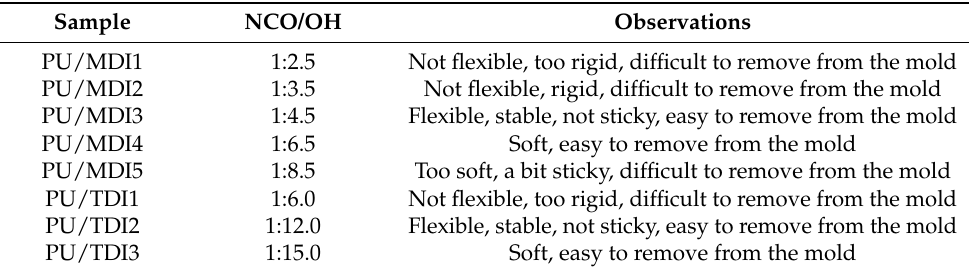
Table 1. NCO/OH weight ratio for PU and its characteristics.